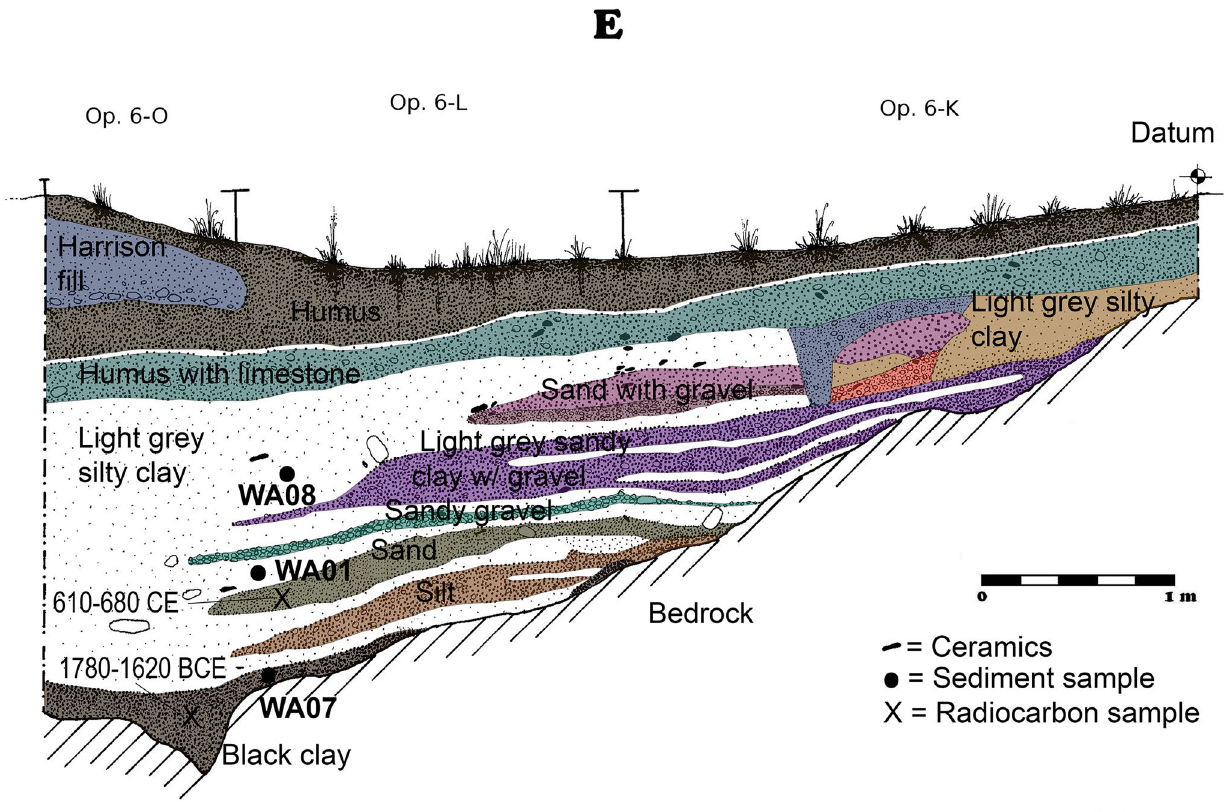
Figure 2. Stratigraphic profile of Palace Reservoir excavations showing Operations K, L and O. Collection locations for samples WA01, WA07 and WA08 are indicated on the profile as well as relevant AMS radiocarbon ( 14 C) dates. The original drawing was prepared by Brian Lane. David Lentz created the final figure using Photoshop CS6, Vers. 13.0.1 × 64 (https:// www. adobe. com/ produ cts/ photo shop/ prici ng- info. html).